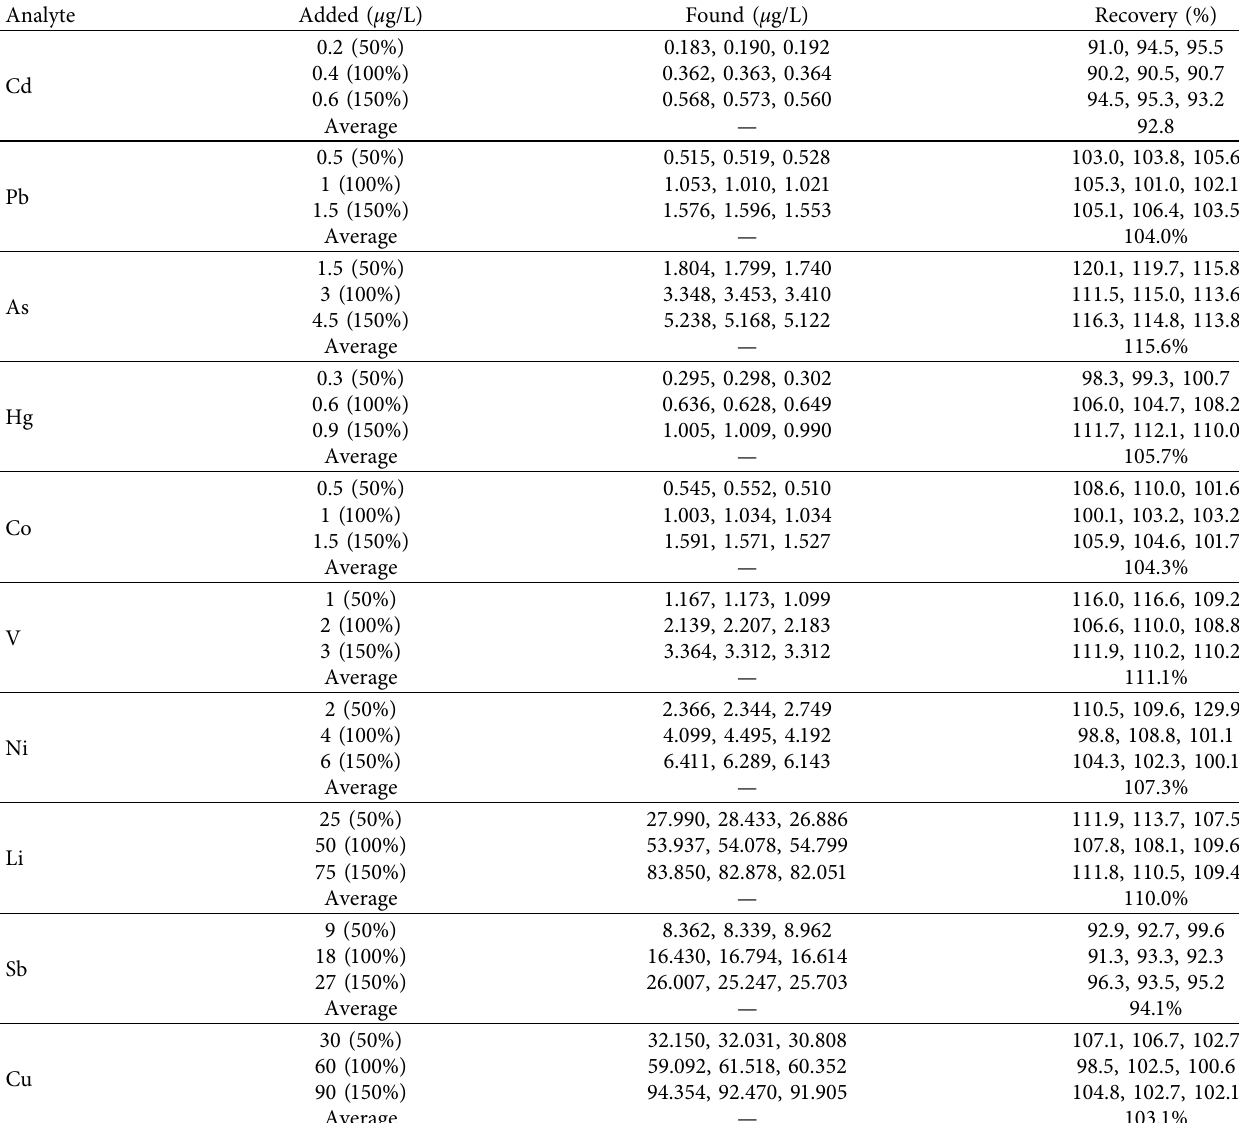
Table 2: Accuracy of 10 elements in parecoxib sodium.